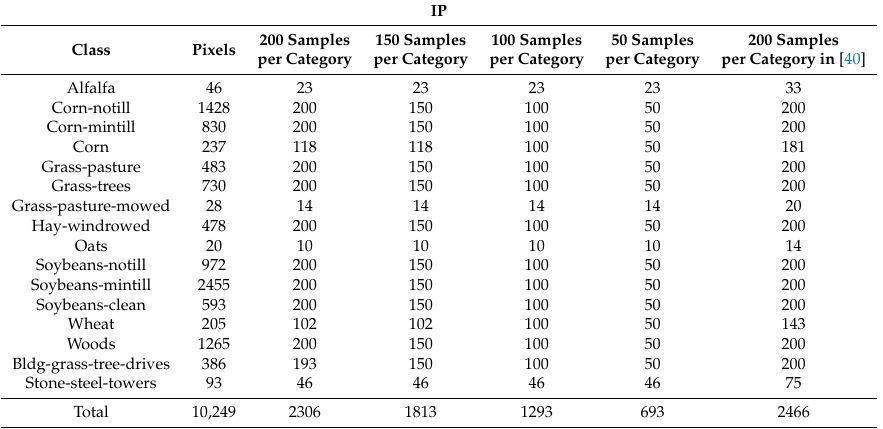
Table 8. Number of training samples used by the spatial-spectral FFPNet for the IP dataset.